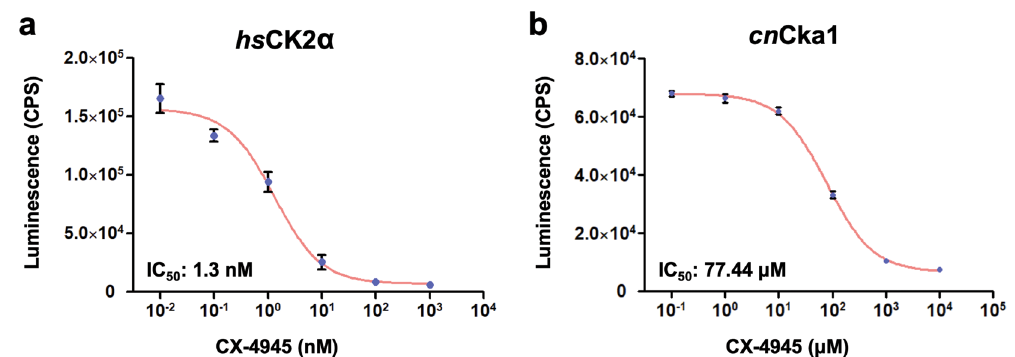
Figure 6. Measurement of the half maximal inhibitory concentration (IC 50 ) of CX-4945 for hs CK2 α and cn Cka1 through in vitro kinase assay. In vitro kinase assay of ( a ) human CK2α and ( b ) C . neoformans Cka1. The recombinant proteins were incubated with CX-4945, respectively, and consumed ATP by each kinase activity. The produced ADP was converted to ATP to be used by luciferase, and the generated luminescence was detected by a luminometer. The counts per second (CPS) is indicative of the kinase activities of hs CK2α and cn Cka1. Three-independent experiments with three-technical replicates were performed and represented in each logarithm graph. The error bar indicates ± S.E.M., and the R-square values are as follows: hs CK2 α (0.9654); cn Cka1